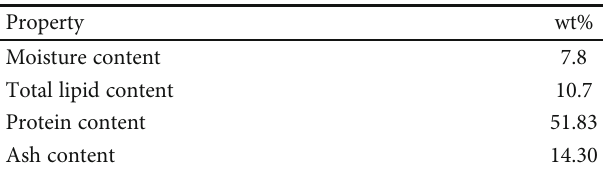
Table 2: Characterization of Spirulina platensis